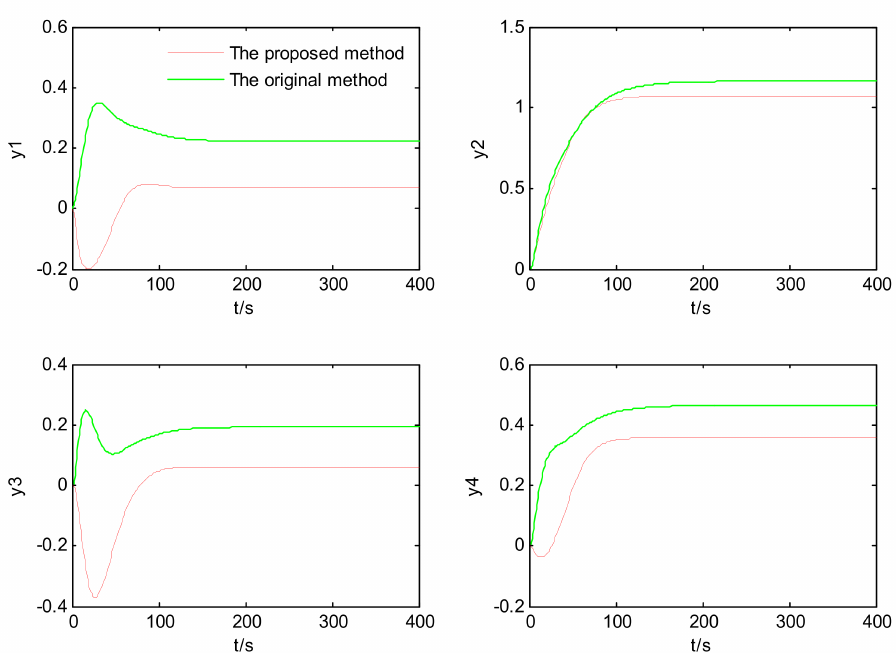
Figure 5. Set-point responses of r 2 = 1 and r 1 = r 3 = r 4 = 0.